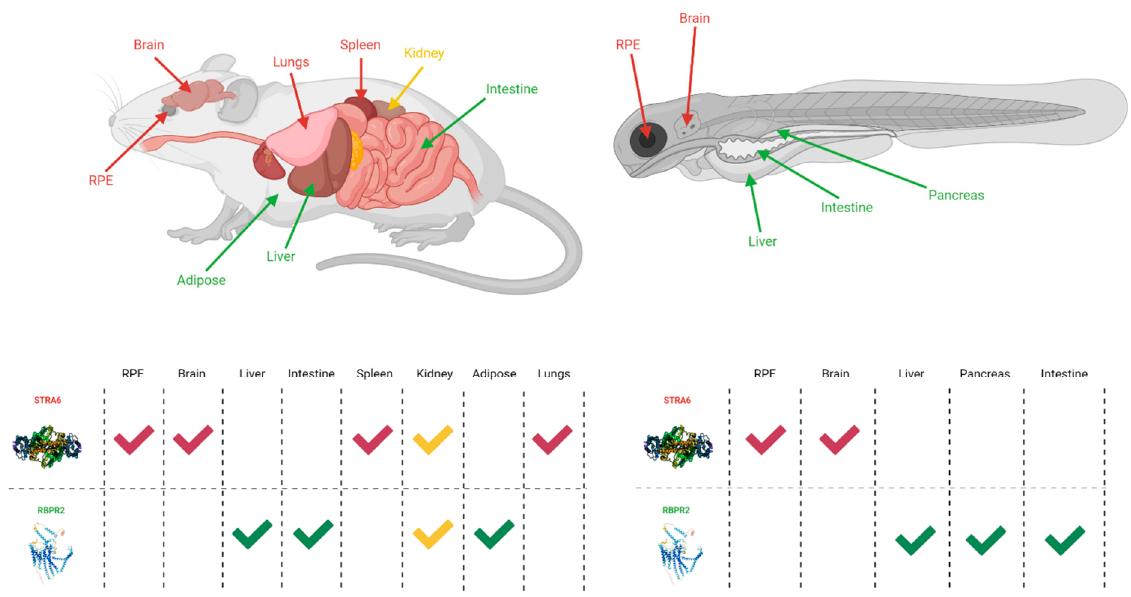
Figure 2. The expression sites of STRA6 and RBPR2 in mouse and zebrafish models [30,35,38–40]. Red arrows and checkmarks indicate STRA6 expression in that particular organ, green arrows and checkmarks indicate RBPR2 expression in that particular organ, and yellow arrows and checkmarks indicate expression of both STRA6 and RBPR2 in that organ. STRA6 is consistently expressed in the retinal pigment epithelium, brain, and shares expression with RBPR2 within the kidneys of both organisms. Otherwise, STRA6 and RBPR2 expression is mutually exclusive. Created with